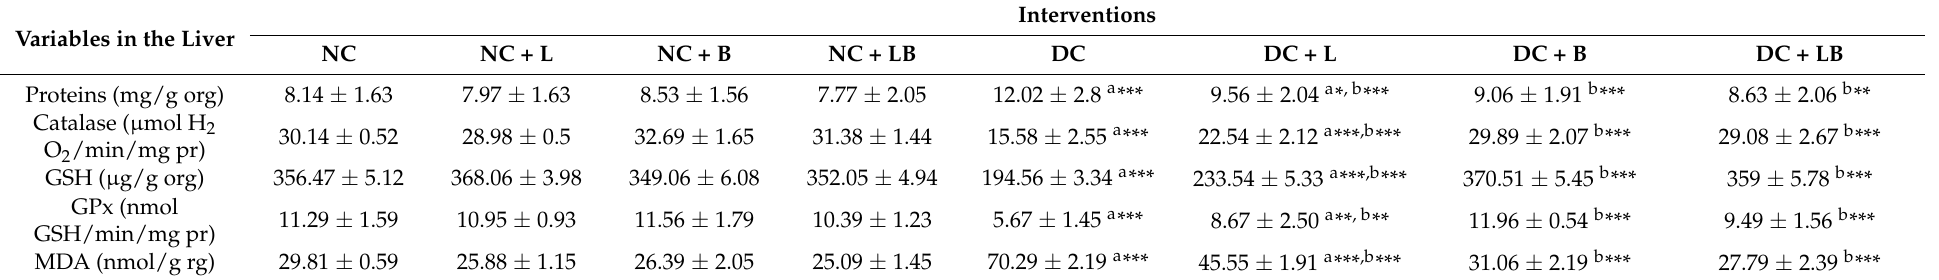
Table 5. Effect of the different treatments on the oxidative parameters in the liver (mean ±